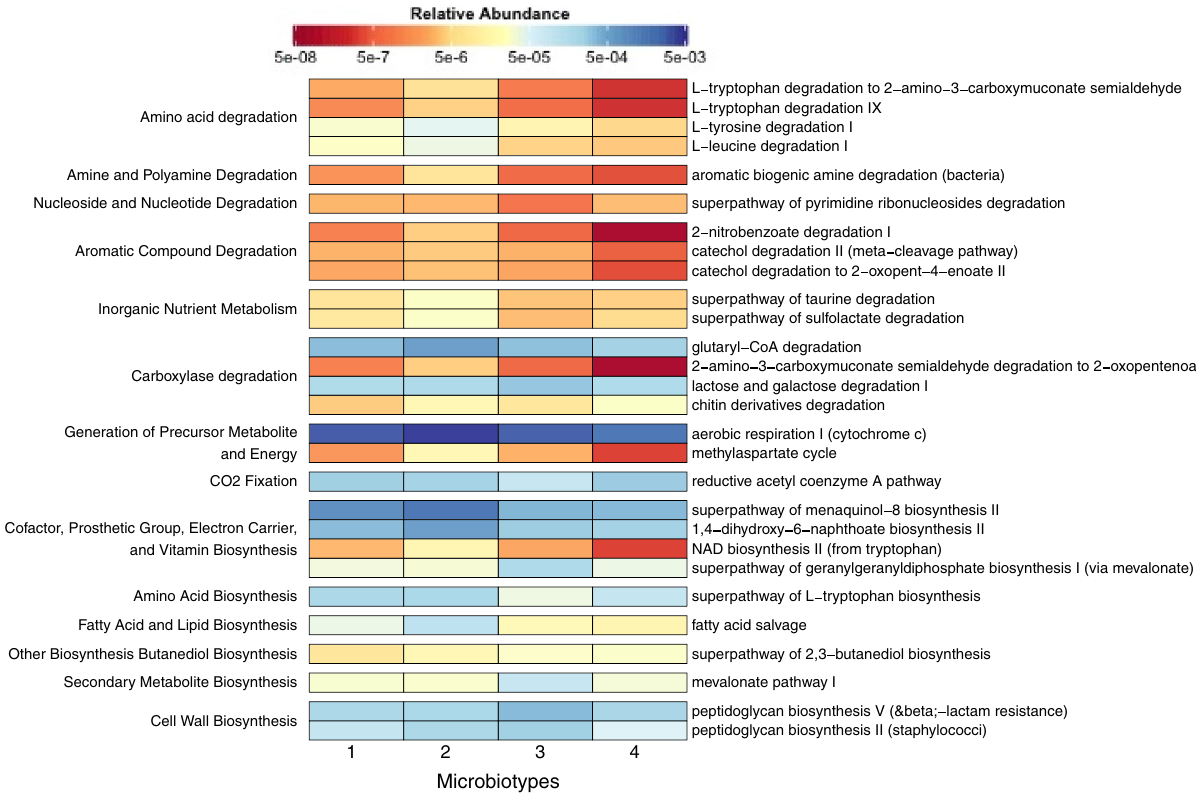
Figure 6. Prediction of the metagenomic functions in the different microbiotypes. Heatmap representing the metabolic pathways, predicted using PICRUSt2, in the four microbiotypes, higher and lower than 1.5 fold changes statistically different [DESeq2 (FDR <